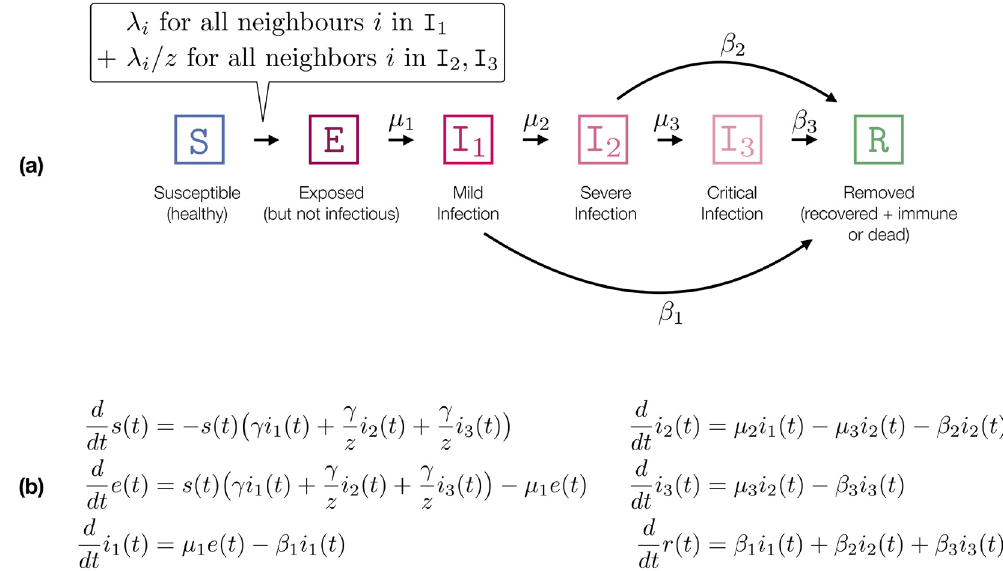
Fig 2. COVID-19 model. (a) Transitioning system of the network model with subject-level infectiousness ( λ i for subject i ). The transition rates refer to exponentially distributed residence times. The expected residence time in each disease stage is the inverse of the sum of the outgoing transitions (e.g. for I 1 it is 1/( β 1 + μ 2 ) = 6 (days)). Likewise, the probability to go to I 2 is 0.2.). (b) Corresponding ODE model with infection rate γ , where γ encodes connectivity and infectiousness.